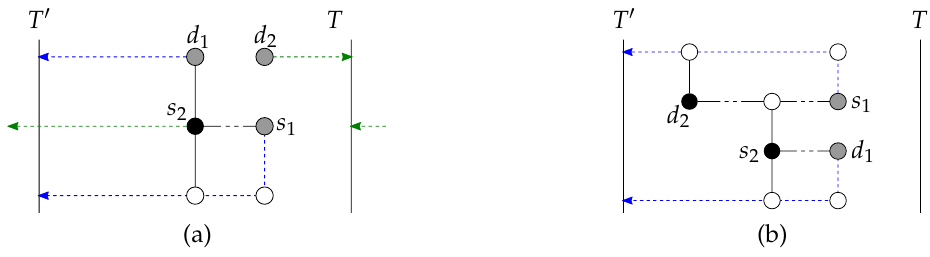
Figure 8. Illustration of the case n = c = 2 with the pair ( s 1 , d 1 ) originally selected to be routed to T (cid:48) . ( a ) The vertex s 2 is fully blocked to T if not going through T (cid:48) . ( b ) Both s 2 , d 2 are fully blocked to T : ( s ) is routed instead to T (cid:48) , and ( s ) to T 2 , d 2 1 , d 1